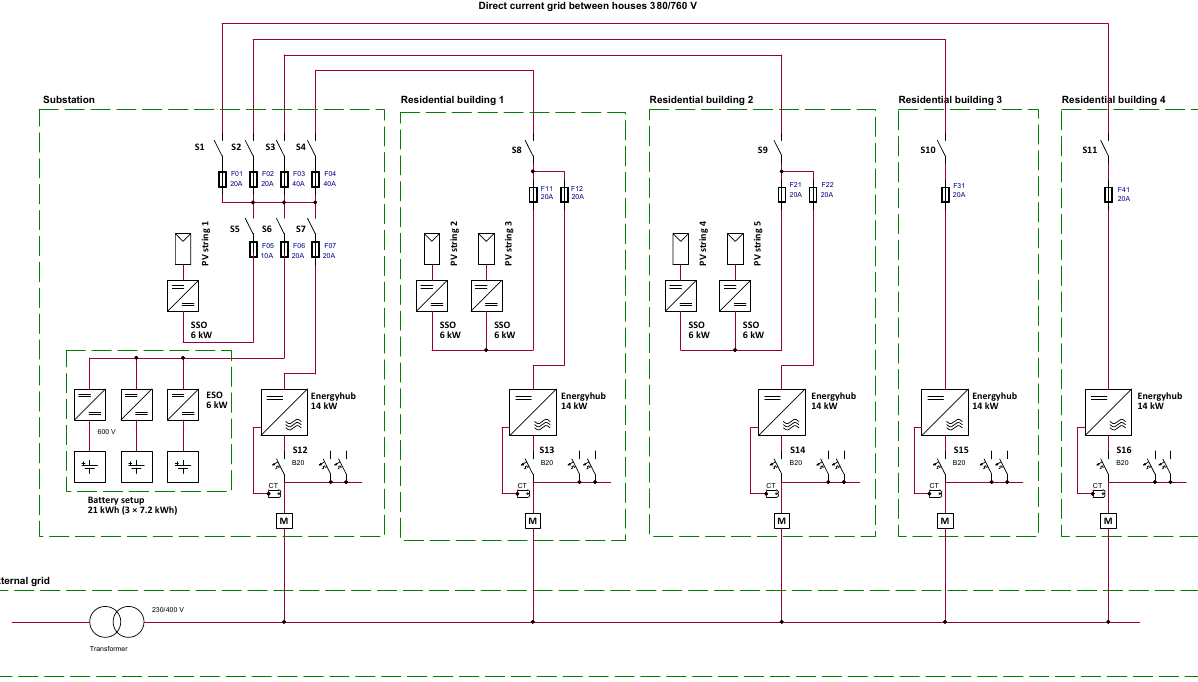
Figure 11. Wiring diagram of the microgrid provided by the system developer.